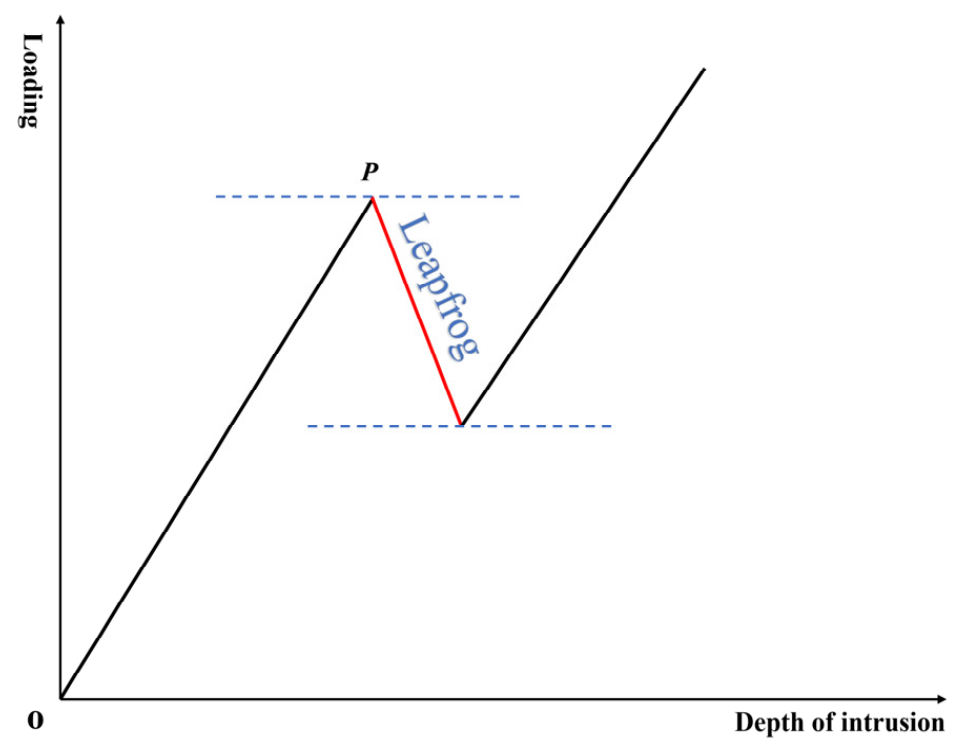
Figure 8. Diagram of the leapfrog intrusion curve.